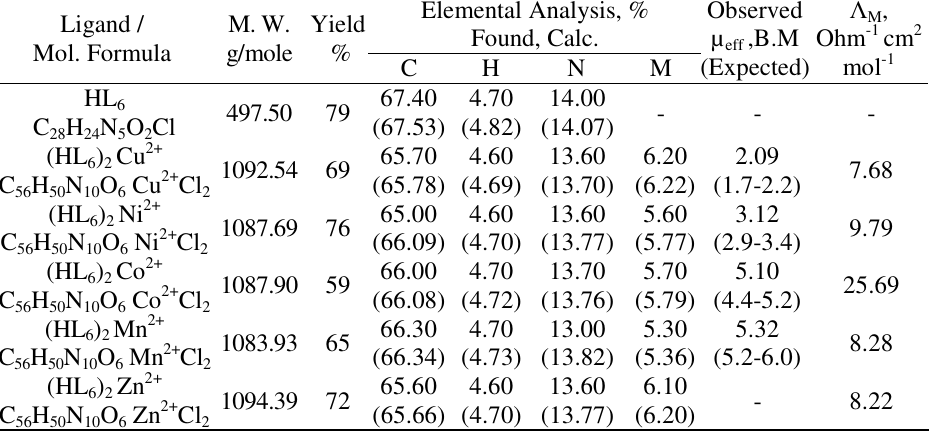
6 Elemental Analysis, % Found, Calc. M